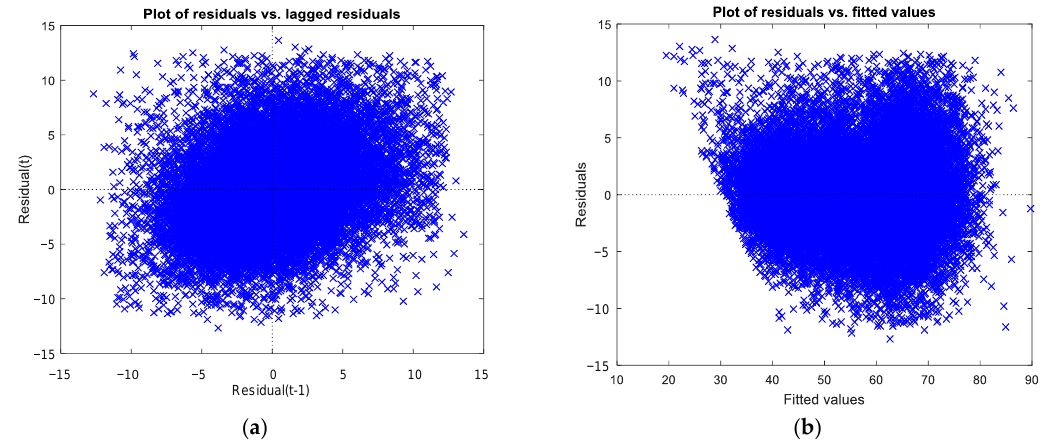
Figure A3. Scatter plot of residuals for the linear model. ( a ) Lagged residuals; ( b ) Residuals for fitted values.